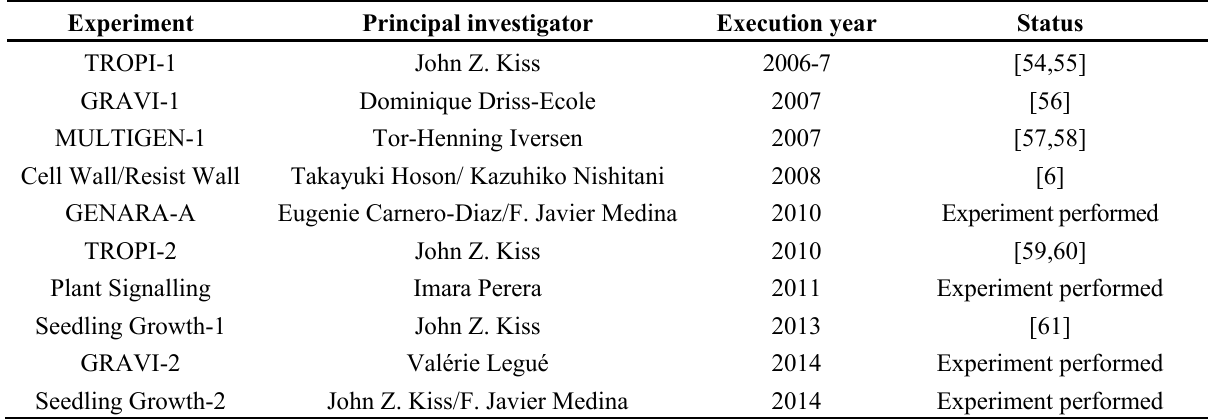
Table 1. Experiments performed in the